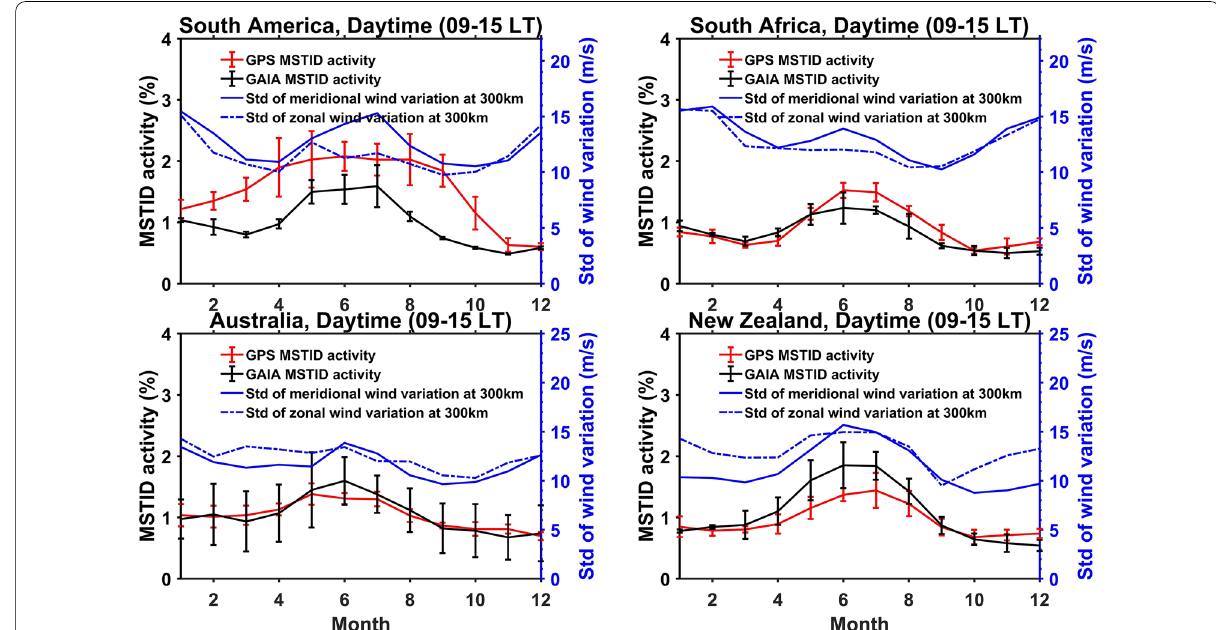
Fig. 5 Same as Fig. 3, but different locations in the southern hemisphere, viz. South America, South Africa, Australia and New Zealand in